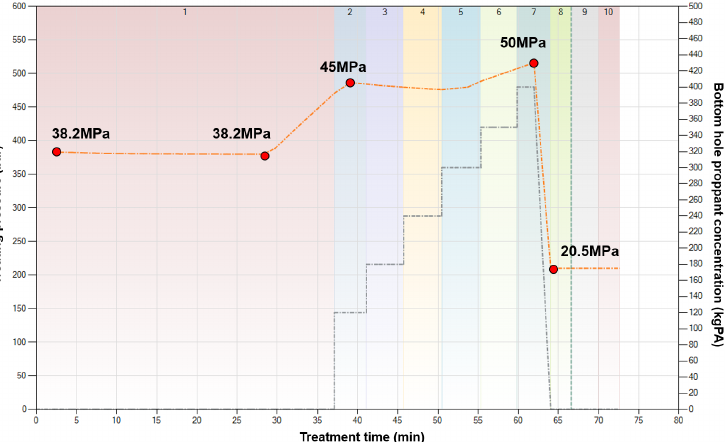
Figure 7. The fitting result of fracturing pressure.